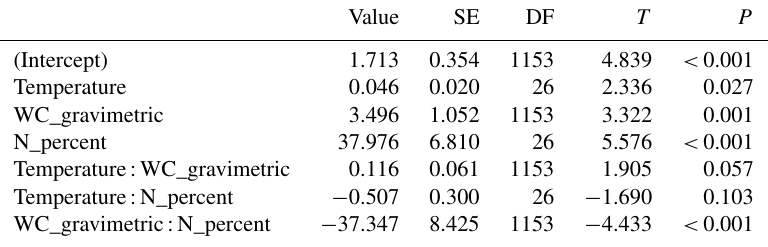
Table 2. Linear mixed-effect model parameters, testing effects of temperature ( ◦ C), gravimetric water content (unitless), soilC (%), soilN (%), and dissolved organic carbon (mgkg − 1 ) on individual core CO 2 fluxes ( + 0.1µgCgC − 1 day − 1 ) ; a colon (“:”) indicates an interaction. Dependent variable has units of log(µgCgC − 1 day − 1 ) . Columns include parameter value, standard error (SE), degrees of freedom (DF), T statistic, and P value. Value SE